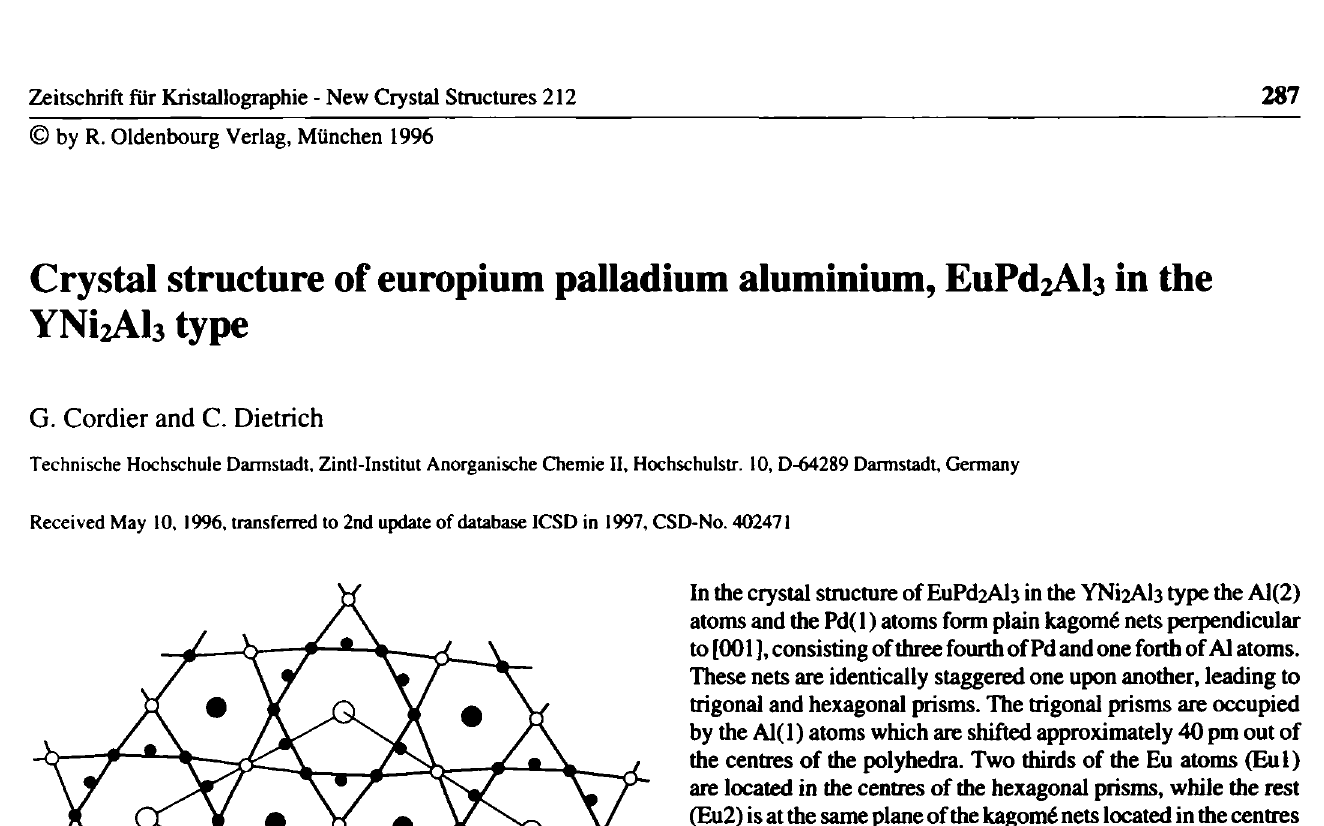
Table 1. Parameters used for the X-ray data collection